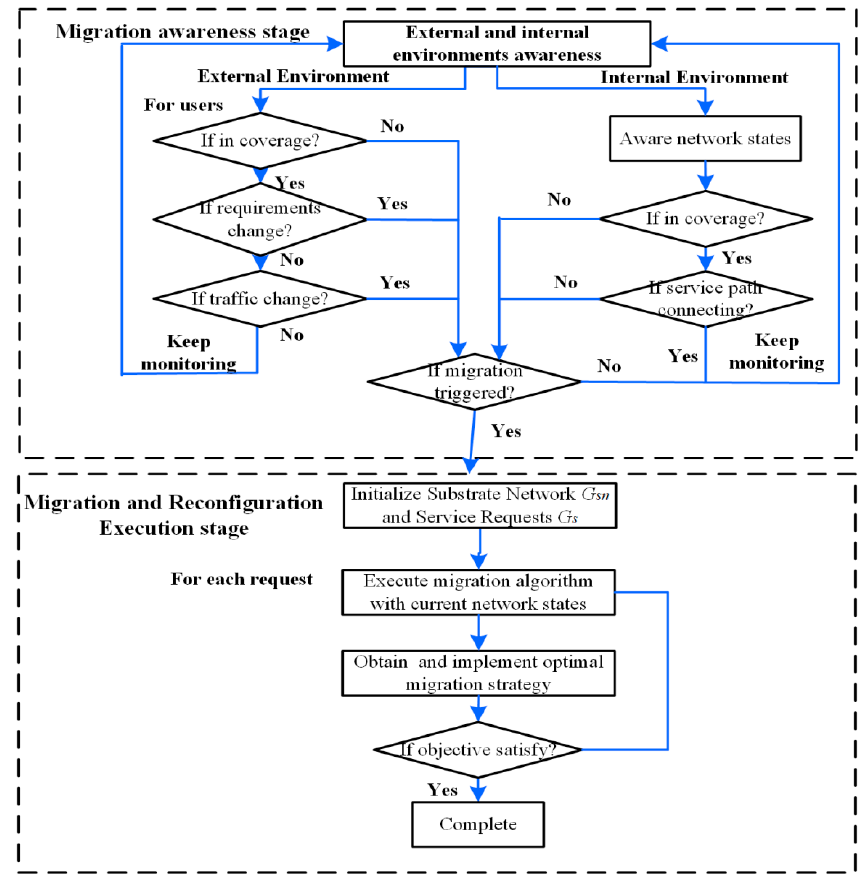
Figure 2. Flowchart of service migration and reconfiguration.